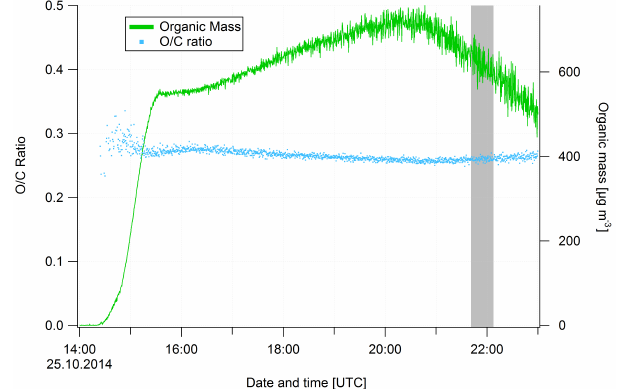
Figure 11. Transition RH at different temperatures. The horizontal lines show the RH range for the transition and the width of the lines represent the temperature uncertainty of 2K. The green curve is the generic SOA estimate from Koop et al. (2011) and the shaded area represents the upper and lower boundary for the